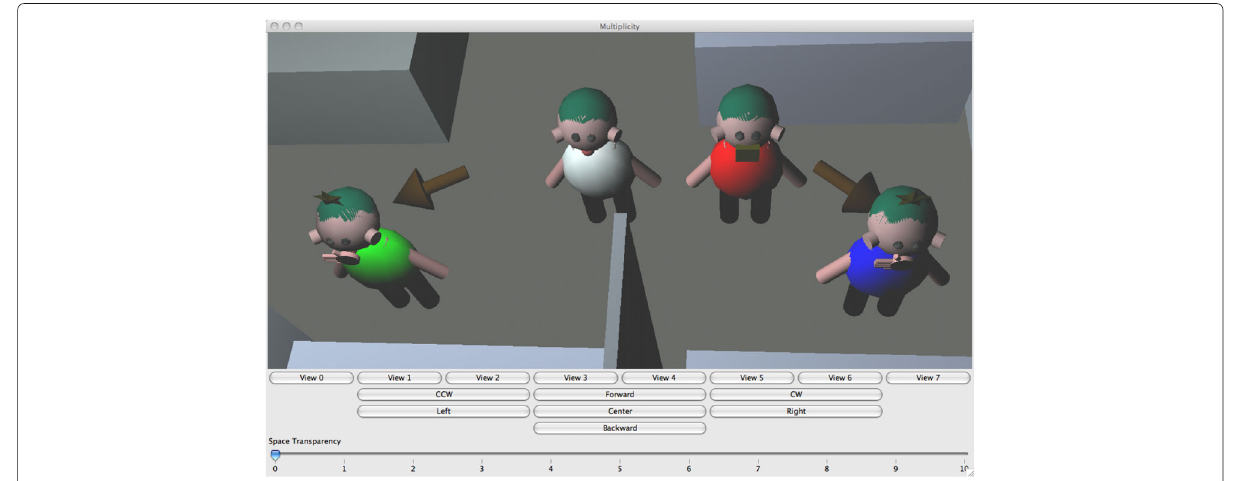
Fig. 7 Stereo localization in a virtual concert can be performed with Multiplicity